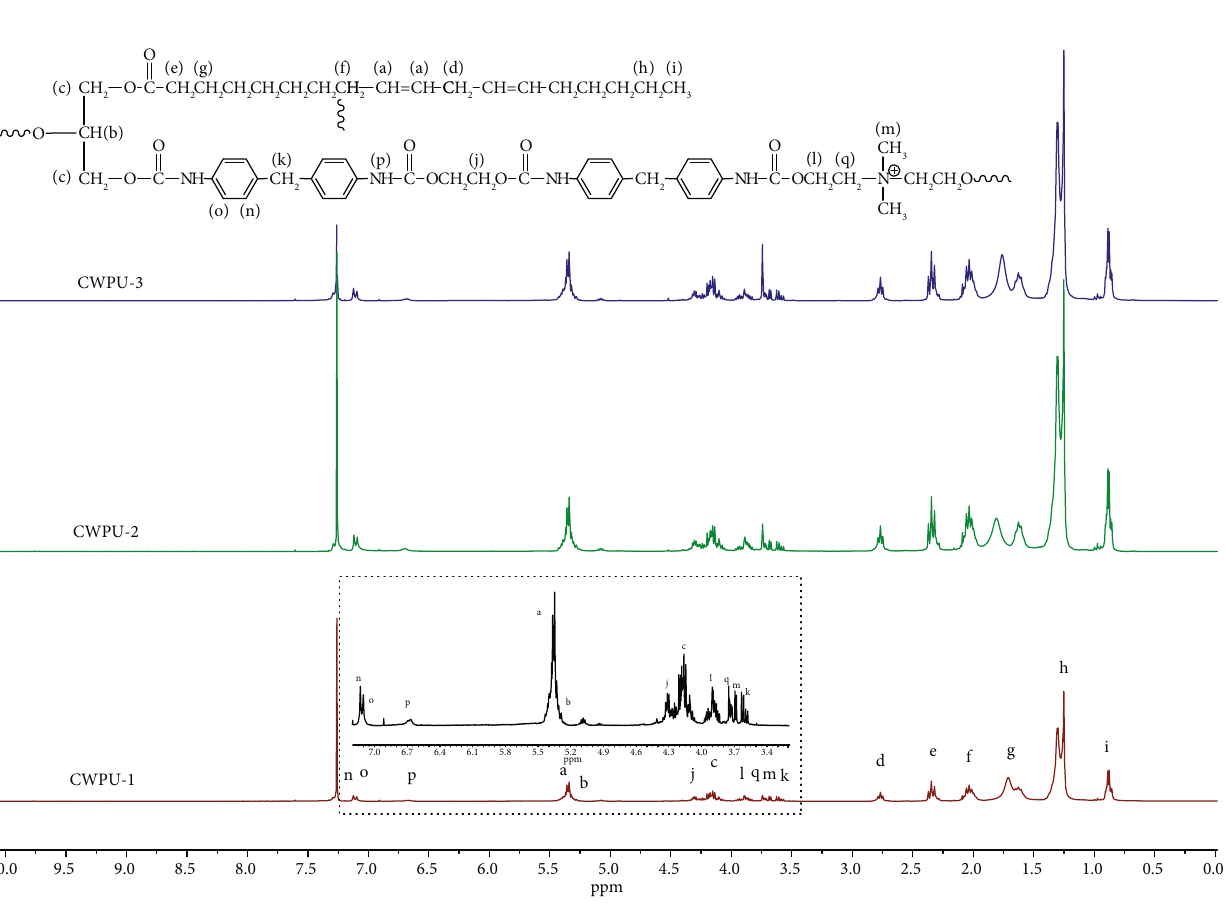
Figure 4: 1 H-NMR spectra of cationic waterborne polyurethanes (CWPUs) with various internal emulsi fi er